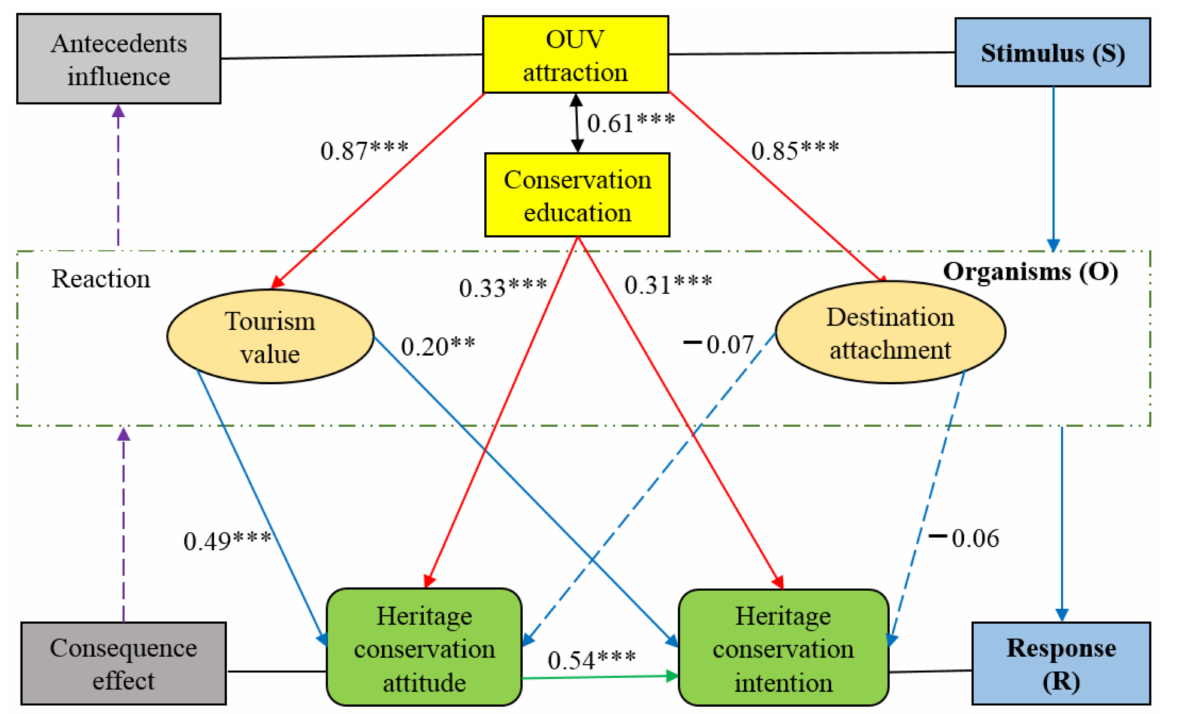
Figure 3. Results of structural model testing and the S‑O‑R framework. Note: significance, ** p < 0.01, *** p < 0.001; the solid line is the significant route, but the blue dotted line is